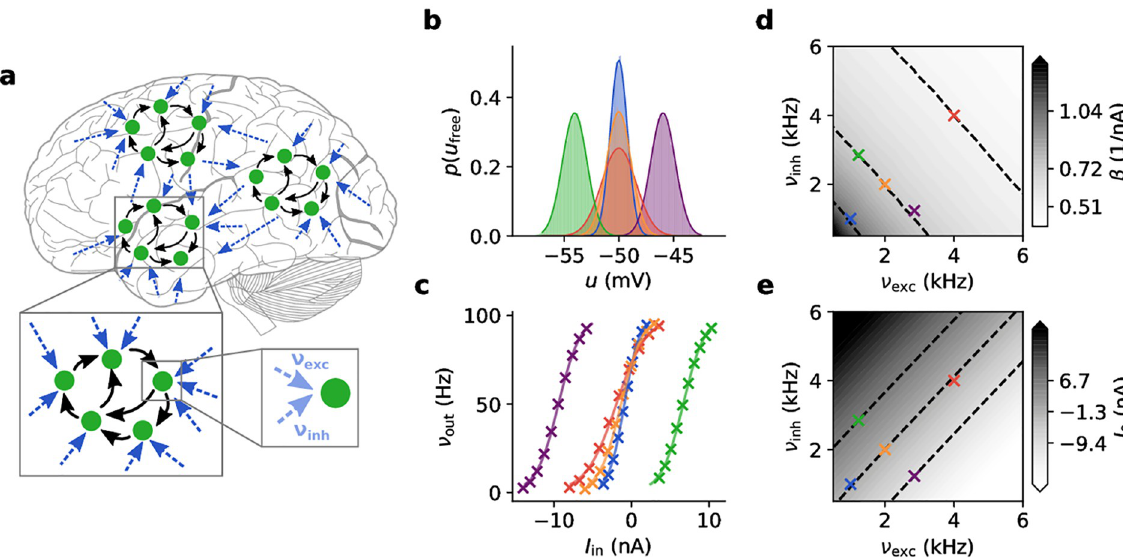
Fig 1. Response functions of neurons in an ensemble. (a) Cortical ensemble of networks. The spike input received by a neuron can be partitioned into functional (solid black arrows) and background (dashed dark blue arrows) input. The background can be partitioned into an excitatory and an inhibitory subset (dashed light blue arrows). In the following panels, we consider one such neuron under five different illustrative background regimes, each of which is assigned a specific color. (b) Steady-state free membrane potential distributions. Shaded areas: numerical simulation; solid lines: analytical approximation using Eqs 1 and 2. Purple, orange, green: same σ u , different μ u ; blue, orange, red: same μ u , different σ u . (c) Corresponding neuronal response functions. Crosses: numerical simulation; solid lines: logistic fit with Eq 3. (d) Slope parameter β and (e) offset I 0 of response functions under various background regimes defined by their respective pairs of excitatory and inhibitory input rates ( ν exc , ν inh ). Dashed isolines indicate configurations of constant slope (cf. Eq 4) or offset, with specific values given as colorbar ticks. Note the approximate linearity of the contour lines.